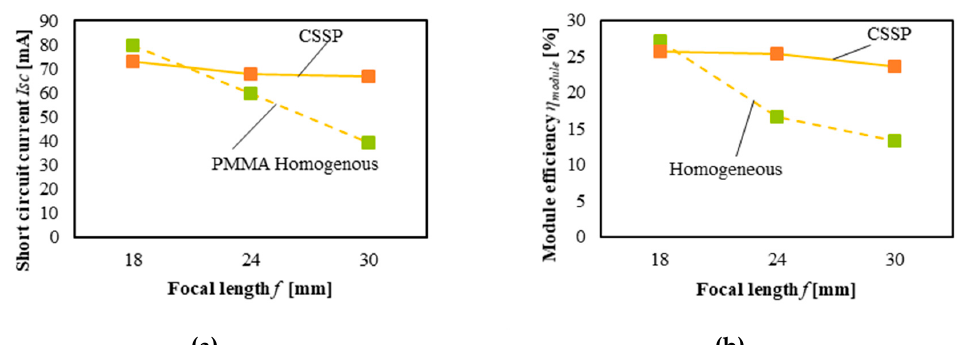
Figure 16. Experimental results of the lens-cell module for the homogenous and CSSP lenses regarding the ( a ) short circuit current and ( b ) module